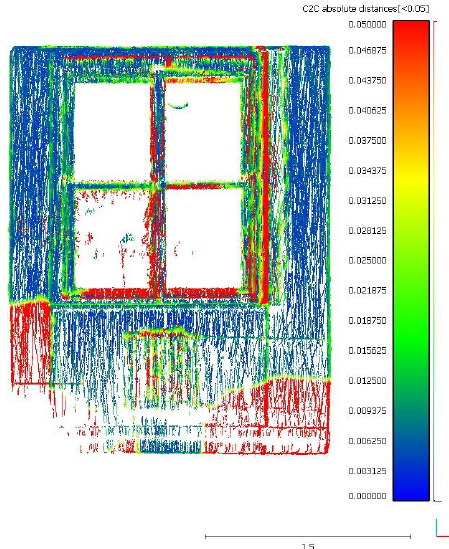
Figure 5 . Cloud-to-cloud comparison on point cloud of a window at the test object n. 2.